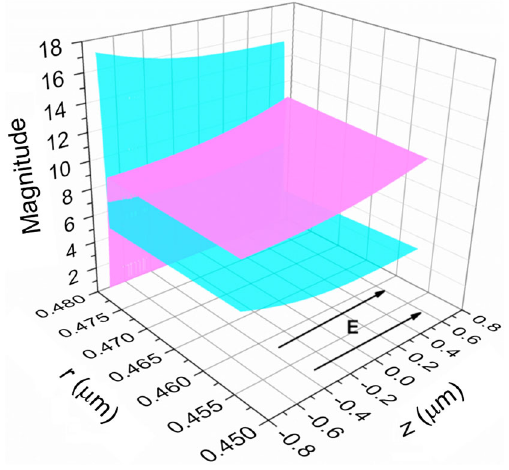
FIG. 11. The distribution of the positive ions (pink) and negative ions (blue) in the central BC section of the cylindrical channel (see Fig. 9), with a radius of 0 . 48 μ m. Here, the red indicates positive ions and blue the negative ions. The magnitude is evaluated as ln ½ 1 þ density = ð 950 μ m − 3 Þ(cid:1) . This distribution is at t ¼ 182 μ s, i.e., at the end of the slowly varying region, as shown in Fig. 10(a). The direction of the externally applied electric field is as shown. The charge densities are seen to be biased by the external field. Along the r direction, only a section close to the fluid-solid interface is